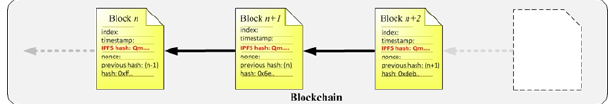
Figure 5 . Integration of IPFS and Blockchain